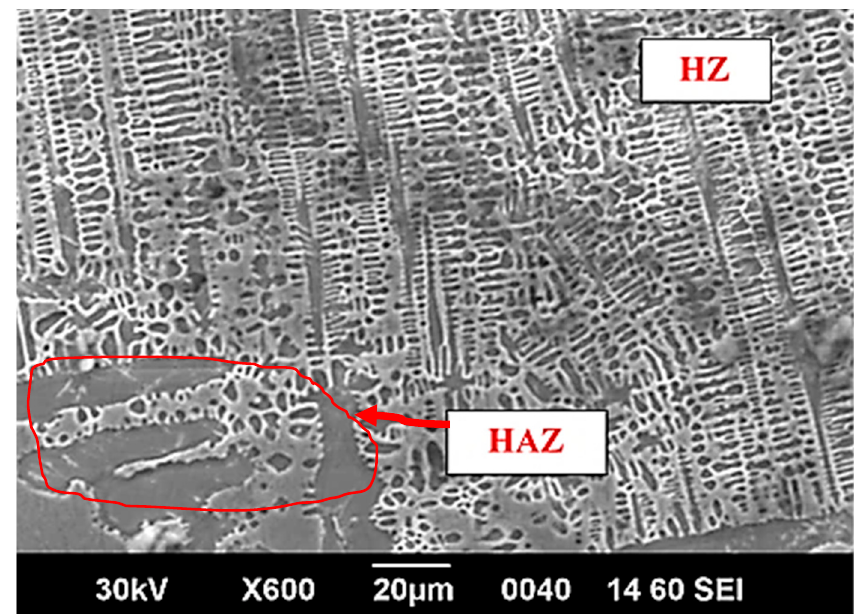
Figure 6. SEM microstructure: of the HZ and the HAZ of S1-1–3 sample.